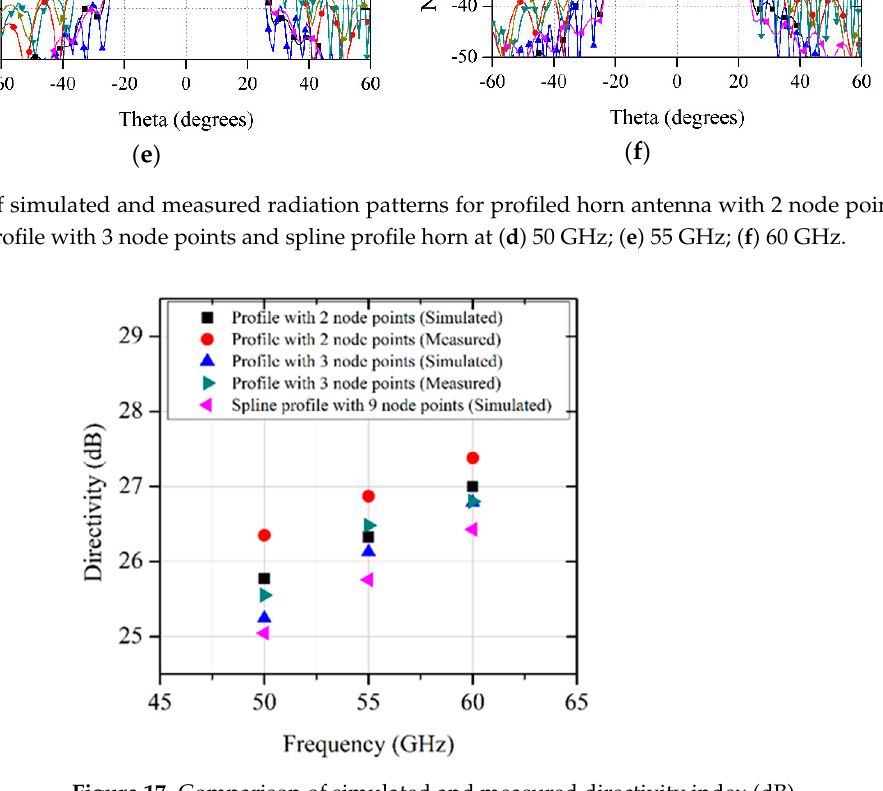
Figure 17. Comparison of simulated and measured directivity index (dB).